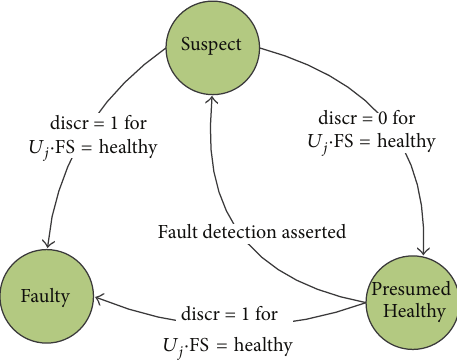
Figure 6: Identifying healthy configurations in a Suspect